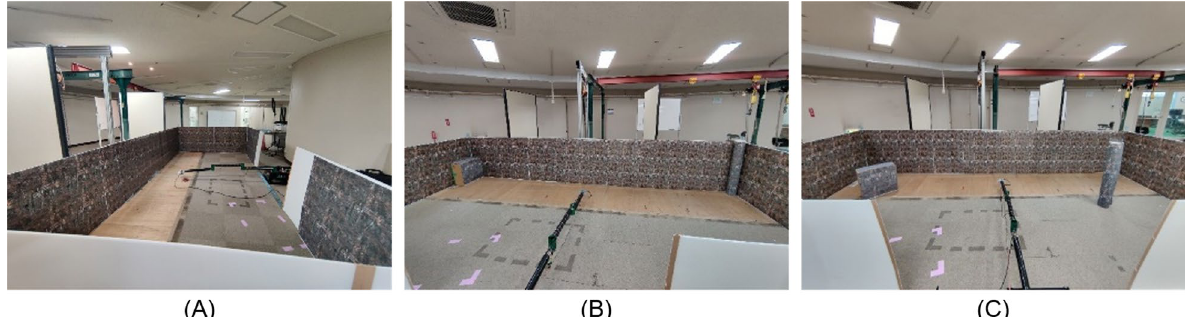
Fig. 12 Three setup patterns for the environment. A The default setup pattern 1 without extra objects. B Setup pattern 2 with box and cylinder placed in the corners. C Setup pattern 3 with box and cylinder placed in specific positions